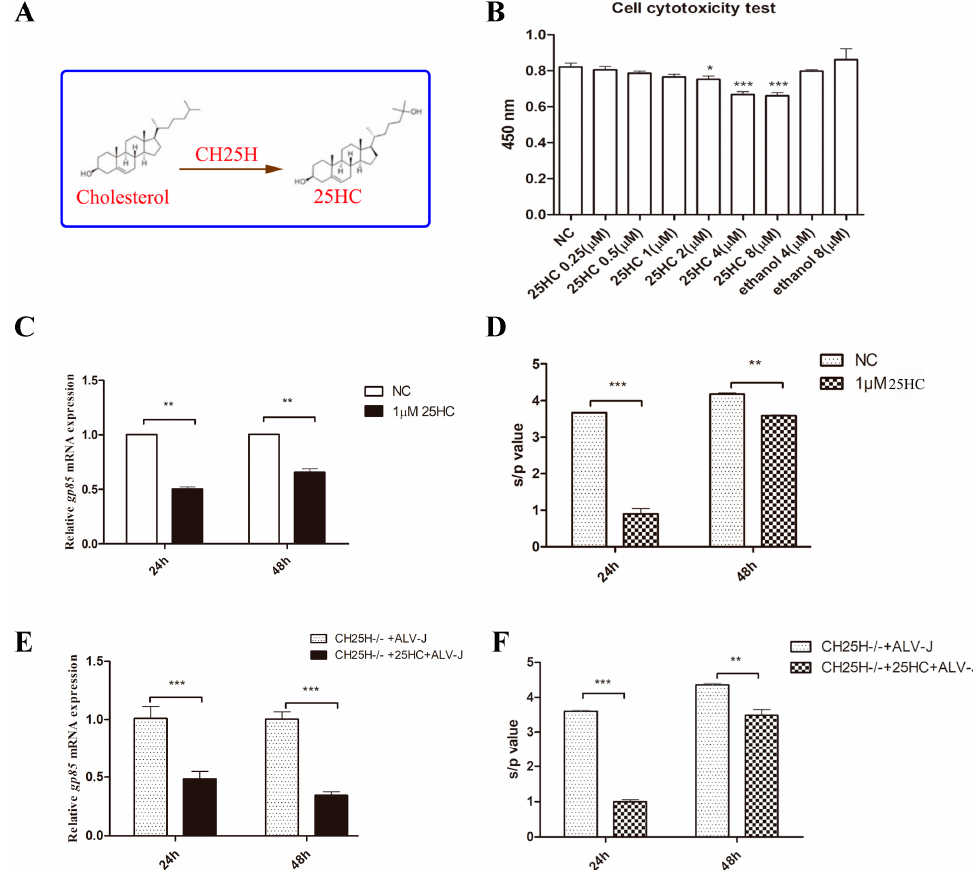
Figure 8. 25HC, the product of chCH25H , inhibits ALV-J replication. ( A ) CH25H converts cholesterol to 25HC. ( B ) DF1 cells were seeded into a 96-well plate and treated with ethanol (4 and 8 µ M) and di ff erent concentrations of 25HC (0.25, 0.5, 1, 2, 4, 8 µ M) for 24 h. A cytotoxicity assay was performed with the Cell Counting Kit-8 dye kit. ( C , D ) DF1 cells were treated with 1 µ M 25HC for 12 h, followed by infection with ALV-J strain SCAU-HN06. The expression of ALV-J gp85 mRNA and p27 protein was detected by qPCR ( C ) and ELISA ( D ) at 24 and 48 hpi. ( E , F ) ChCH25H - knockout DF1 cells were treated with 1 µ M 25HC for 12 h, followed by infection with ALV-J strain SCAU-HN06. The expression of ALV-J gp85 mRNA and p27 protein was detected by qPCR ( E ) and ELISA ( F ) at 24 and 48 hpi. DF1 cells and chCH25H -knockout DF1 cells pretreated with ethanol were used as control (NC). * p < 0.05; ** p < 0.01; *** p < 0.001.